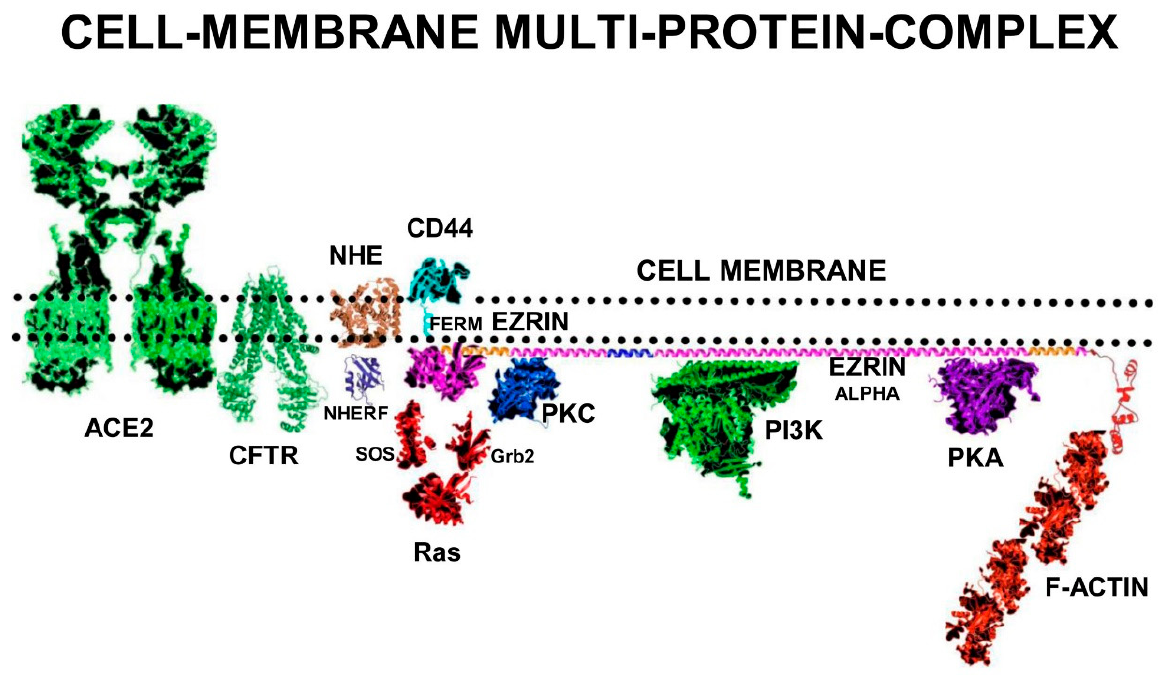
Figure 1. A cell-membrane multi-protein-complex comprising of the ACE2 receptor for SARS-CoV-2, CFTR, NHE, NHERF, Ezrin, CD44, SOS, Grb2, Ras, PKC, PI3K, PKA, and F-actin. SARS-CoV-2 binds to ciliated-epithelial-cells that express Angiotensin-Converting Enzyme 2 (ACE2) and transmembrane serine protease 2 (TMPRSS2) on their apical cell-